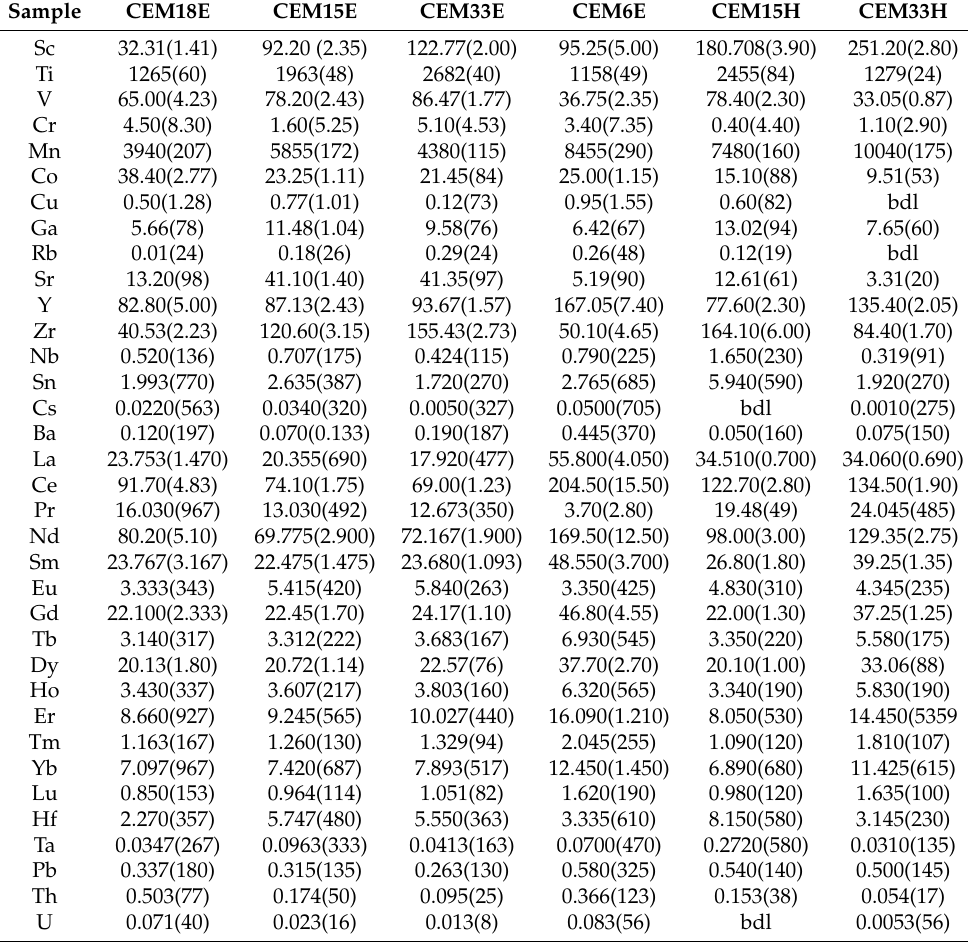
Table 3. Compositions of trace elements (in ppm) for the studied clinopyroxenes. 1 σ in